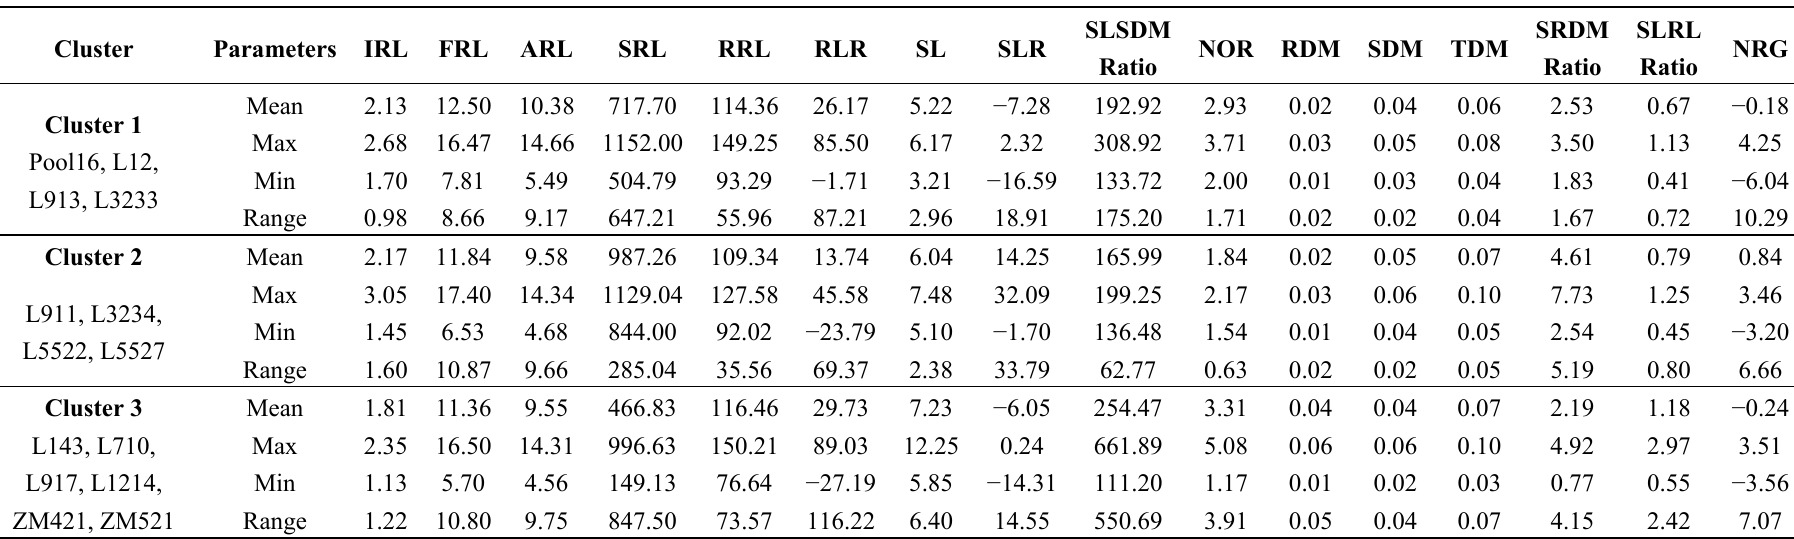
Table 8. Cluster membership, mean, maximum, minimum, and range of seedling characteristics of each